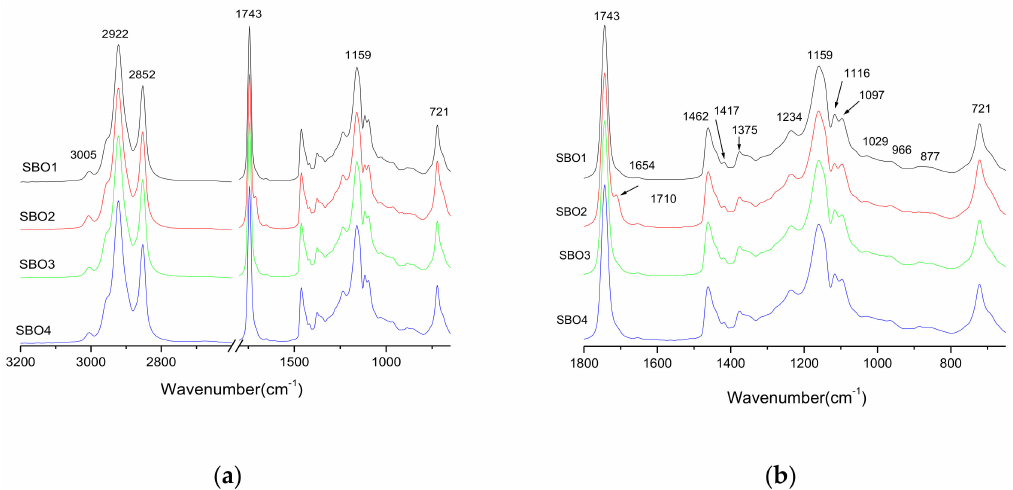
Figure 2. Comparative ATR-FTIR spectra for sea buckthorn (SBO) oils (SBO1-SBO4) in the whole region (3600–650 cm − 1 ) ( a ) and in the fingerprint region (1800–650 cm − 1 ) ( b